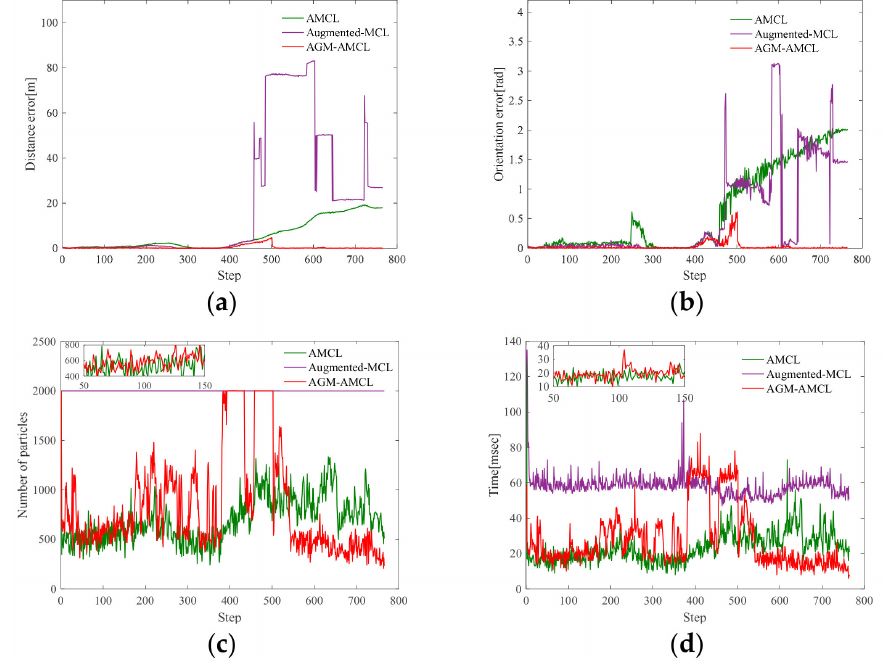
Figure 15. Localization results in scene C: ( a ) distance error; ( b ) orientation error; ( c ) number of particles; ( d ) running time. The zoomed results from step 50 to 150 show that our localization method has similar running time with AMCL. Our method takes less time from step 600 to 800 while more time is need from step 400 to